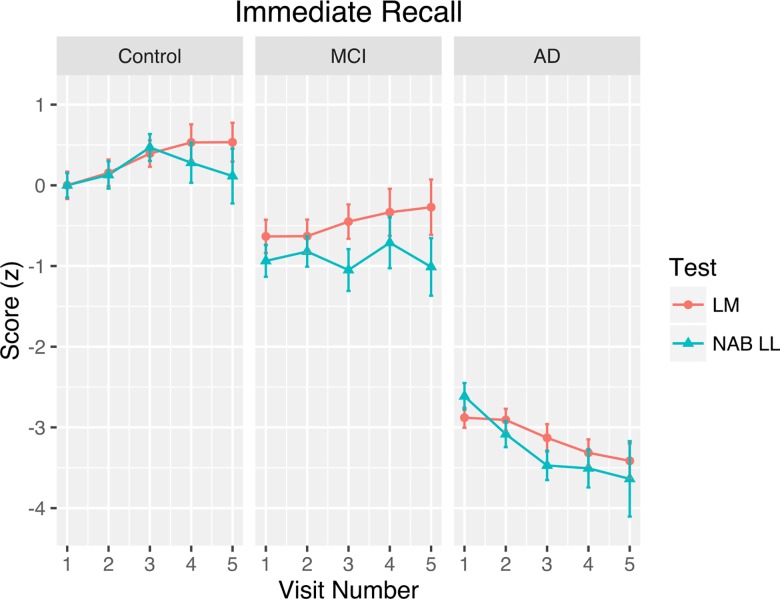
Immediate Recall Practice Effects.Standardized test scores on the immediate recall condition as a function of visit number, test, and clinical diagnosis. Error bars represent 95% confidence intervals and account for within-subjects variability.